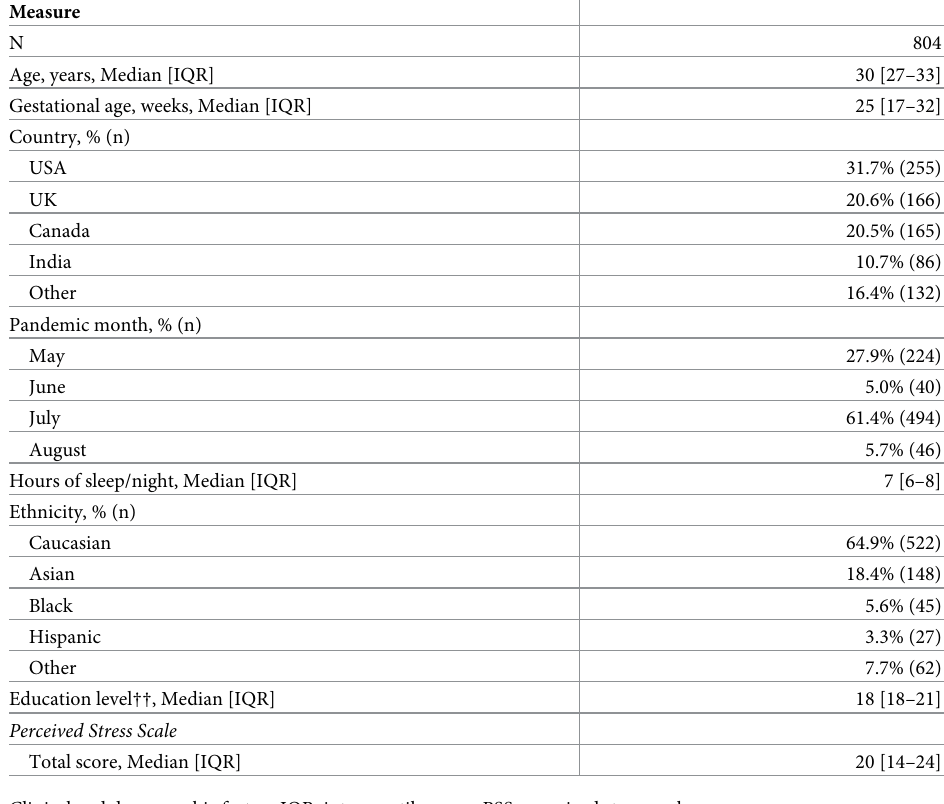
Table 1. Demographic information of pregnant